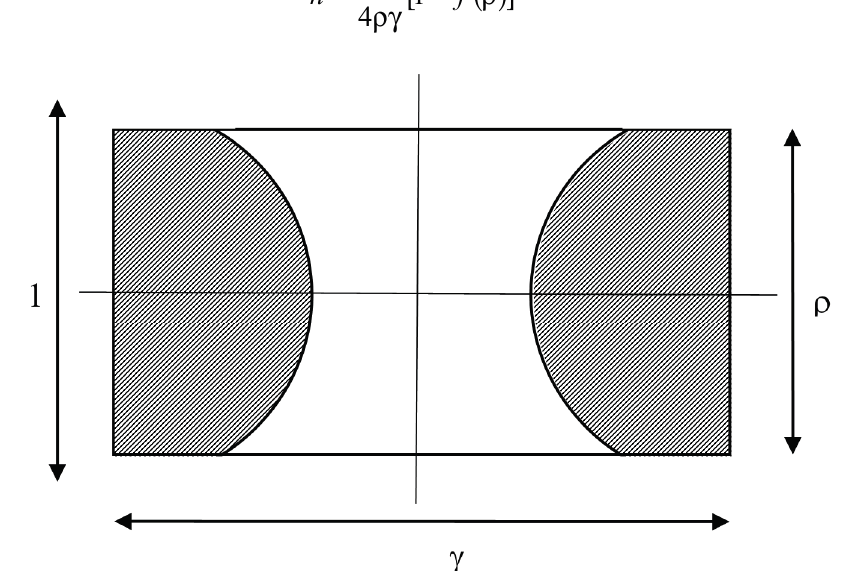
Figure 9. As for Figure 5, but with closer actuator